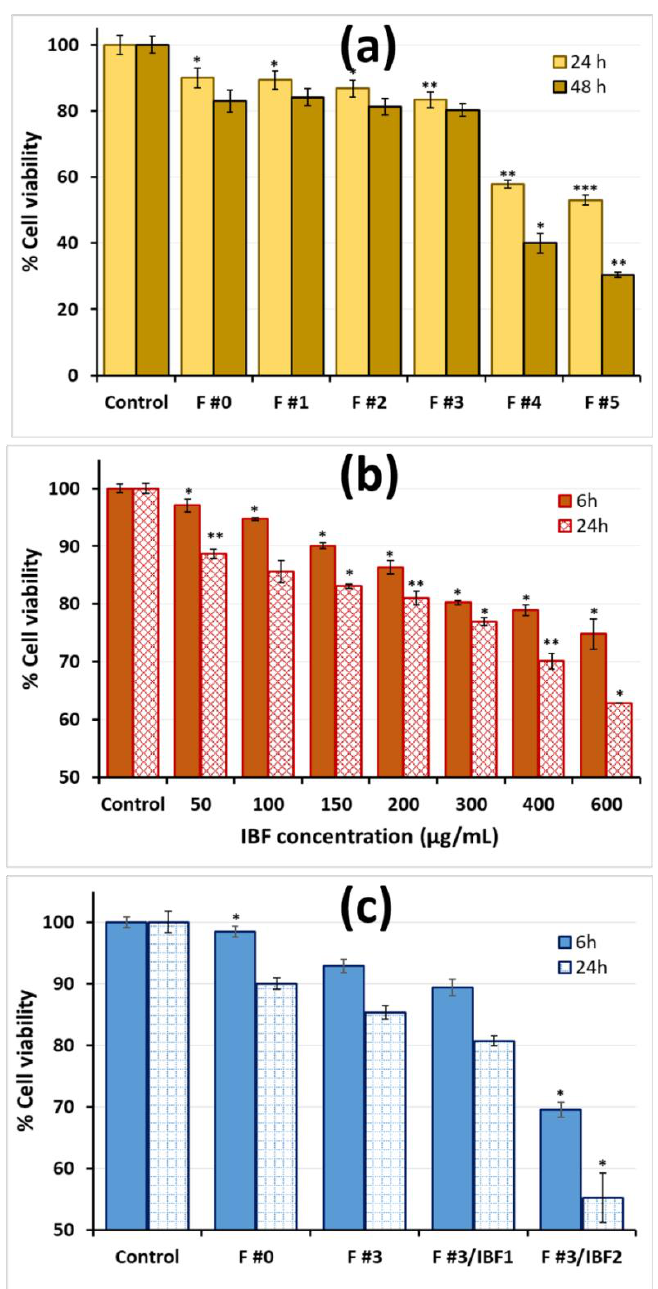
Figure 11. Viability of human dermal fibroblast adult (HDFa) cells exposed for different periods of time to pure and composite PVA/OxCS with AgNps ( a ), different sodium ibuprofen concentrations ( b ), and composite PVA/OxCS-AgNps with different ibuprofen content ( c ), assessed by MTT assay. Results are expressed as mean ± standard deviations (n = 3). * p < 0.05, ** p < 0.01, *** p < 0.001, compared with control (untreated cells).